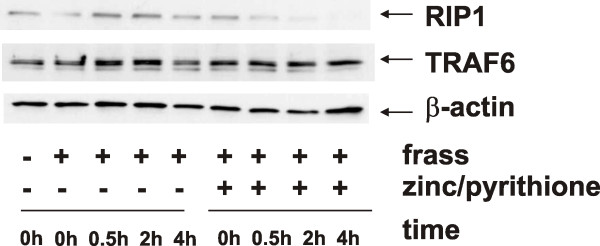
RIP1 and TRAF6 protein levels following GC frass with or without zinc supplementation. HL-60 cells were treated with GC frass (1 μg/ml) or LPS (1 μg/ml) with or without zinc gluconate (1 μM) and pyrithione (10 μM) for times as indicated (0-4 hr). Cell lysates were harvested, separated by gel electrophoresis and probed with antibodies against RIP1, TRAF6 or β-actin. This experiment was performed 3 times.